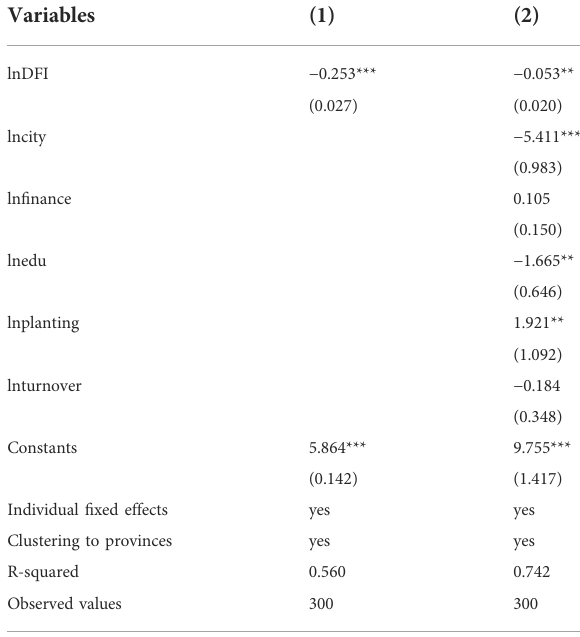
TABLE 3 Test of agricultural non-point source pollution abatement effect of digital fi nancial